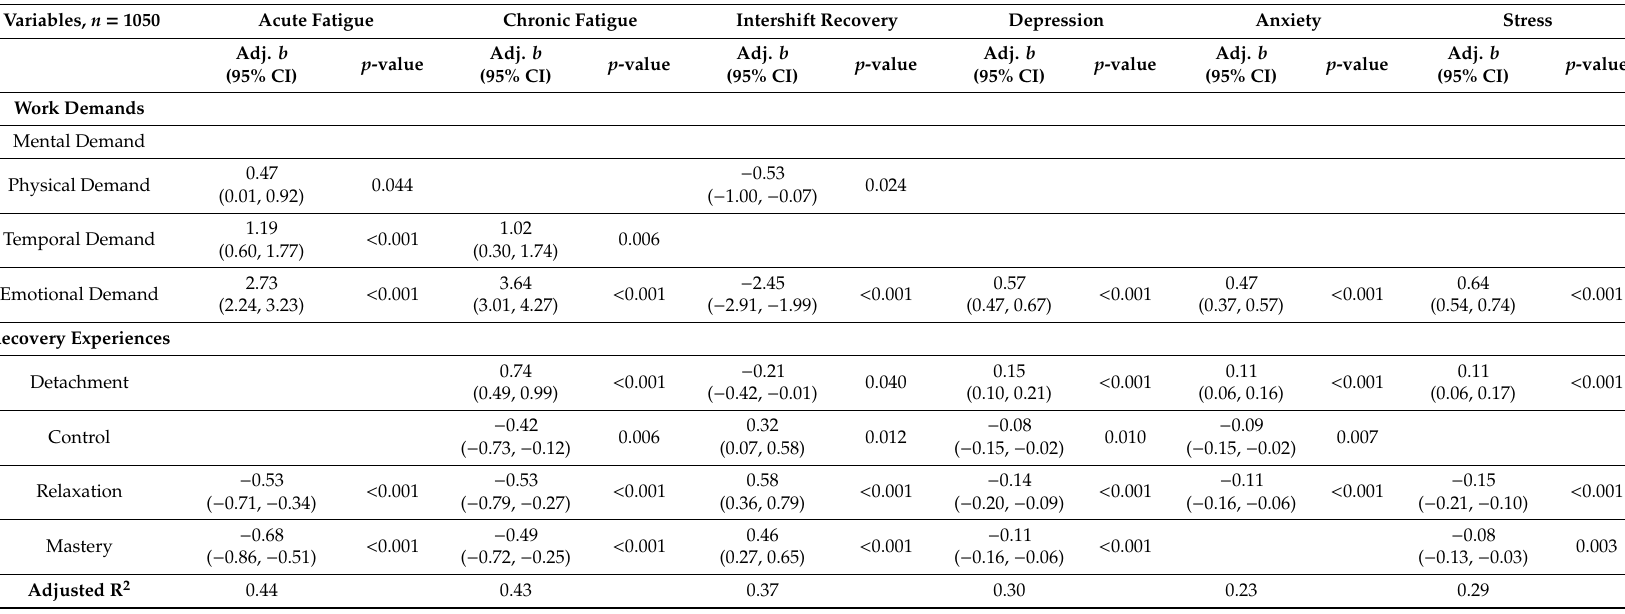
Table 6. Association of work demands and recovery experiences with multiple mental health parameters